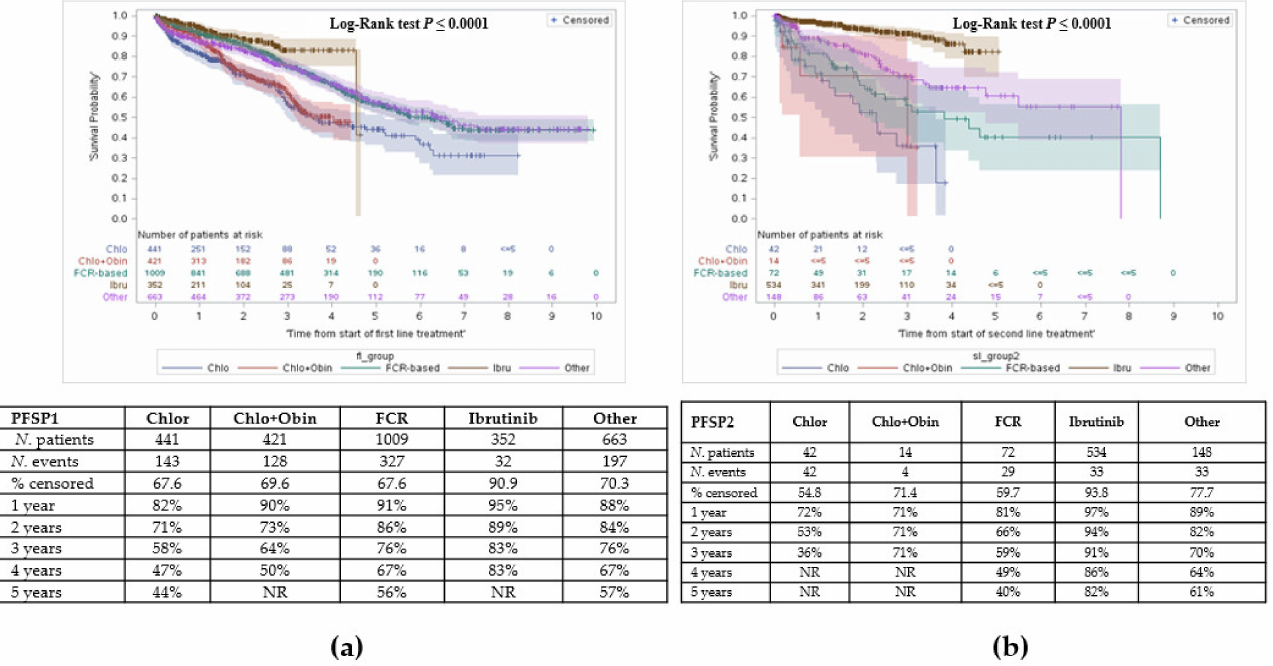
Figure 4. Time between treatments. ( a ) Time from initiation of first line treatment to second line treatment; ( b ) Time from initiation of second line treatment to third line